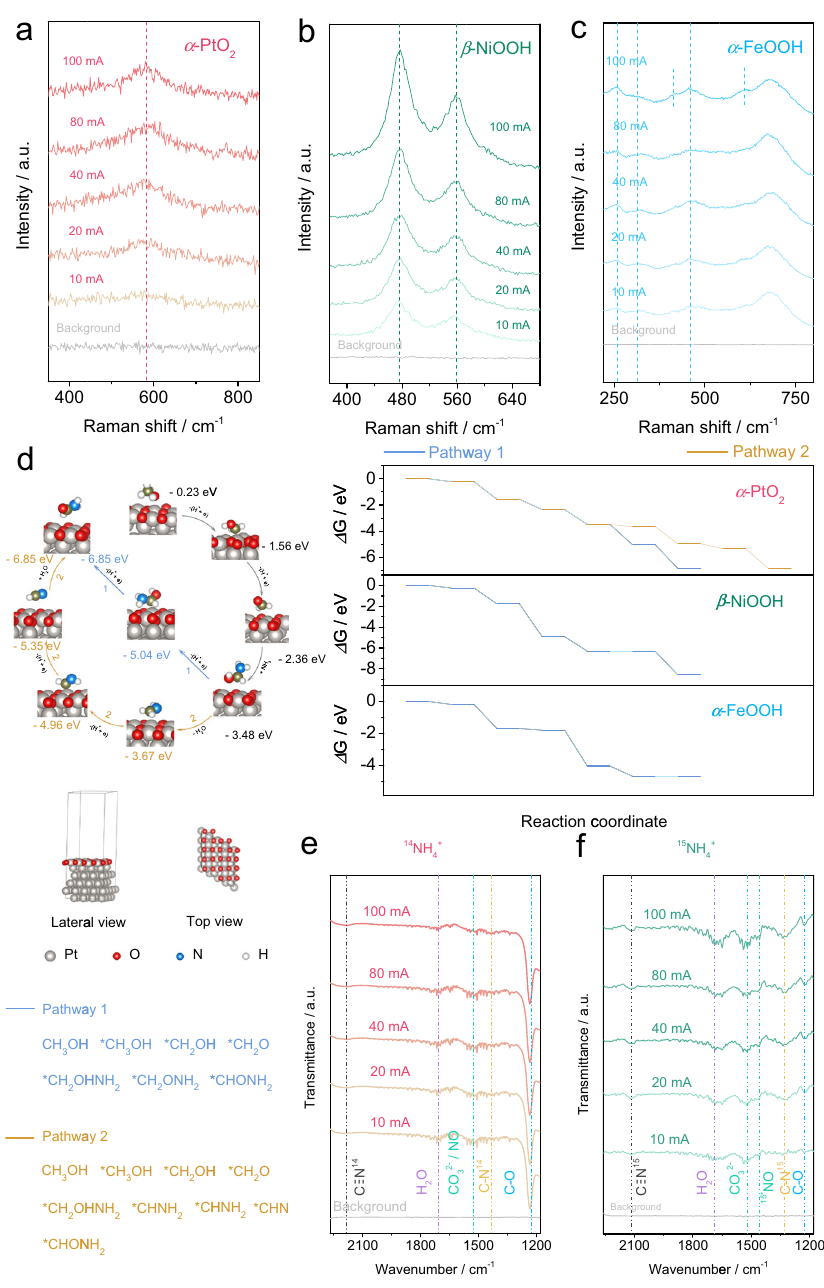
Fig. 3 | The super fi cial active sites, mechanism, and reaction intermediates analysis.a – c Thecurrent density-depended RamansignalsofPt, Ni,and Fe. d The theoretical model of α -PtO 2 , formamide formation pathway over its surface and